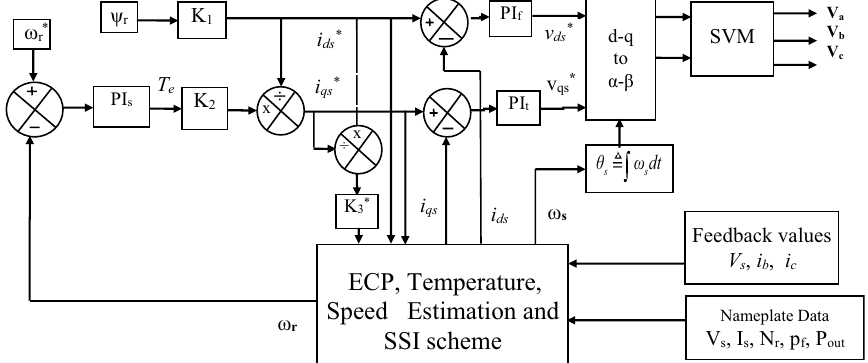
Fig. 3 Schematic of IFOC